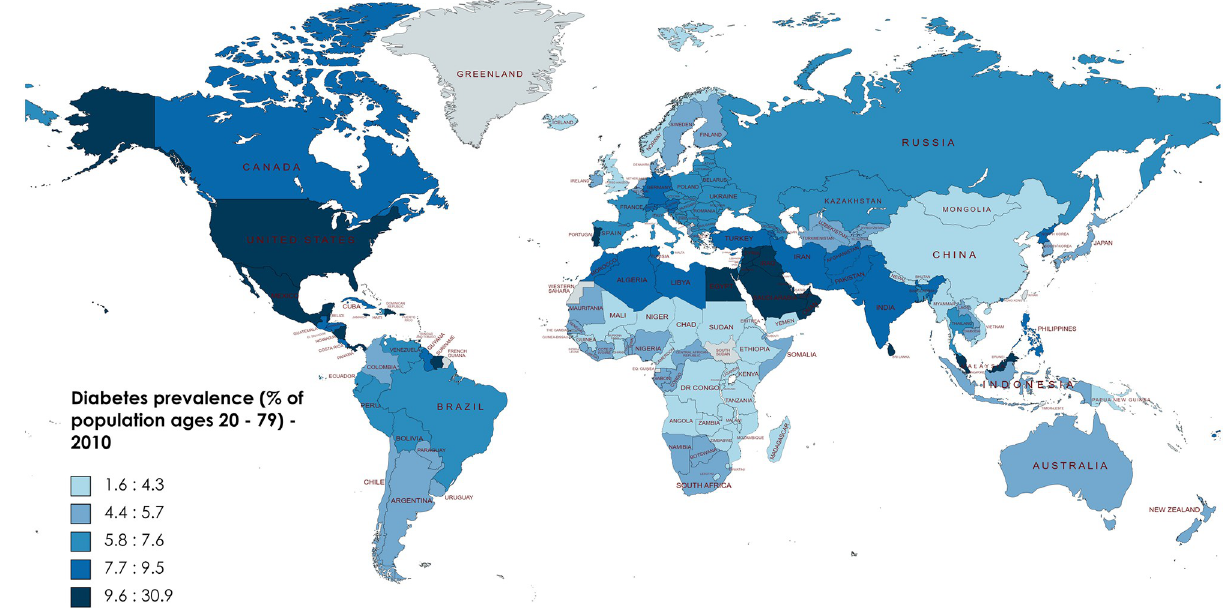
Fig 1. Diabetes prevalence, 2010 (% of population ages 20 to79). The map was created with Mapchart.net.